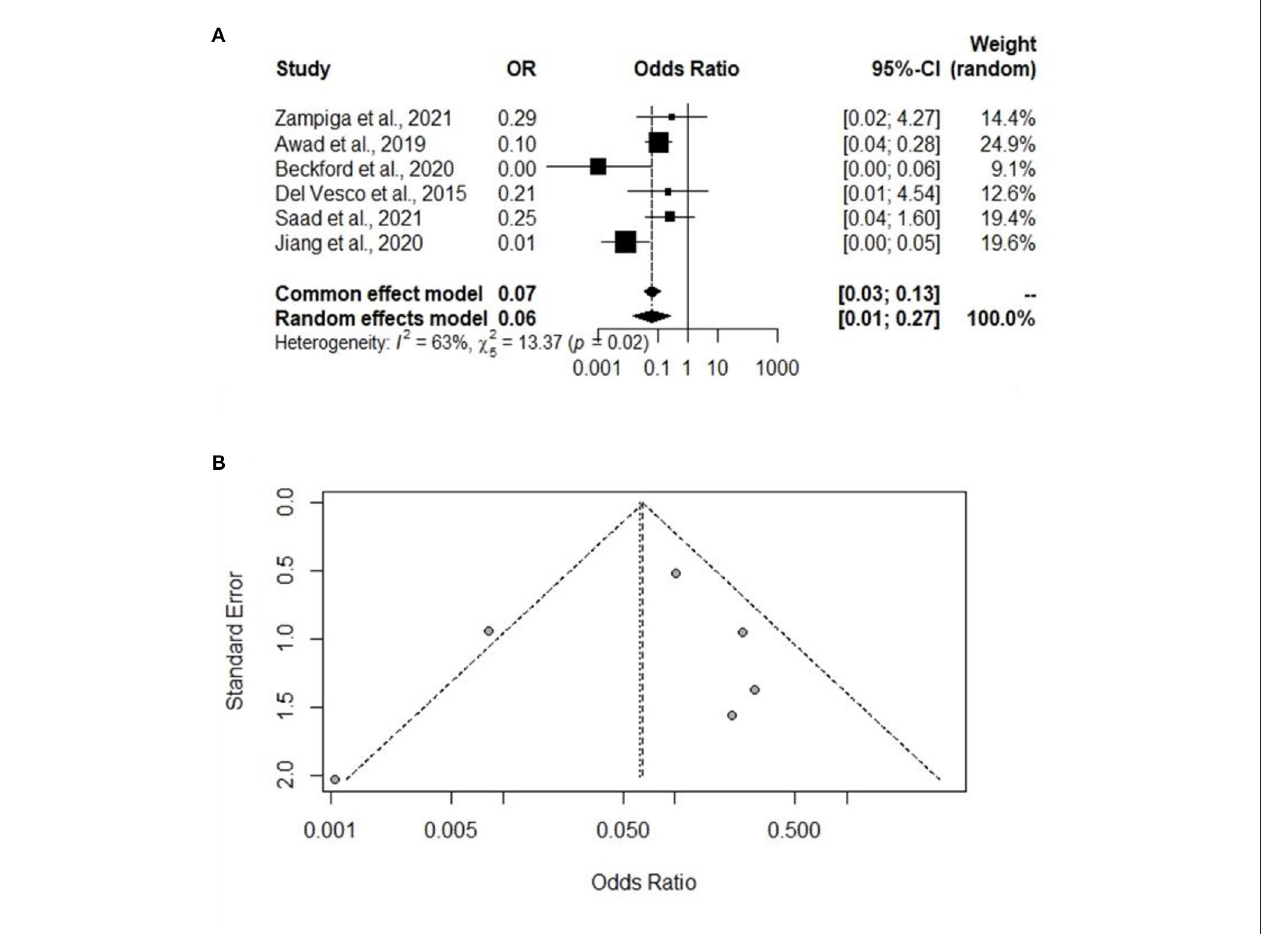
FIGURE 6 | Forest plot and funnel plot representing the effect of heat stress on broiler mortality rate. (A) Forest plot indicates that the heat stress significantly increases the mortality rate and (B) symmetric funnel plot consistent with lower likelihood of publication bias of our selected journal related mortality